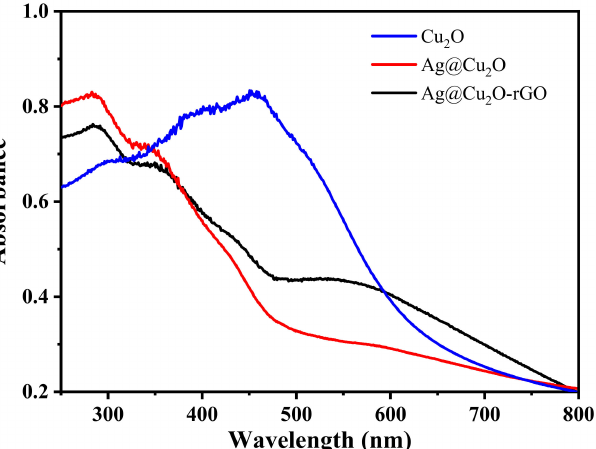
Figure 3. UV–Vis absorbance spectra of Cu 2 O, Ag@Cu 2 O, and Ag@Cu 2 O-rGO composite structures.